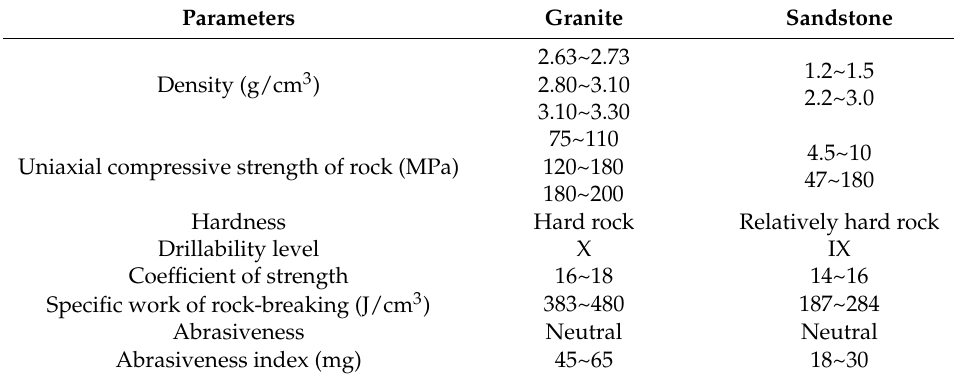
Table 7. Material parameters of the rocks.